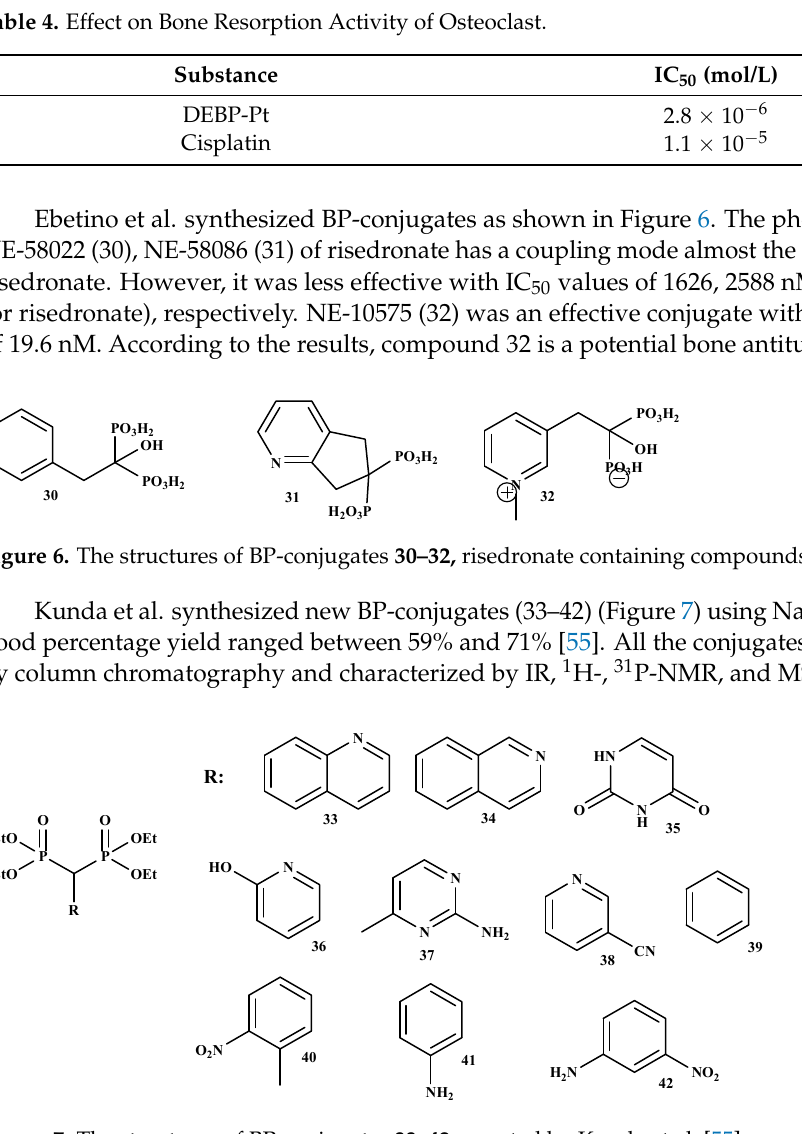
Figure 7. The structures of BP ‐ conjugates 33–42 reported by Kunda et al. [55].